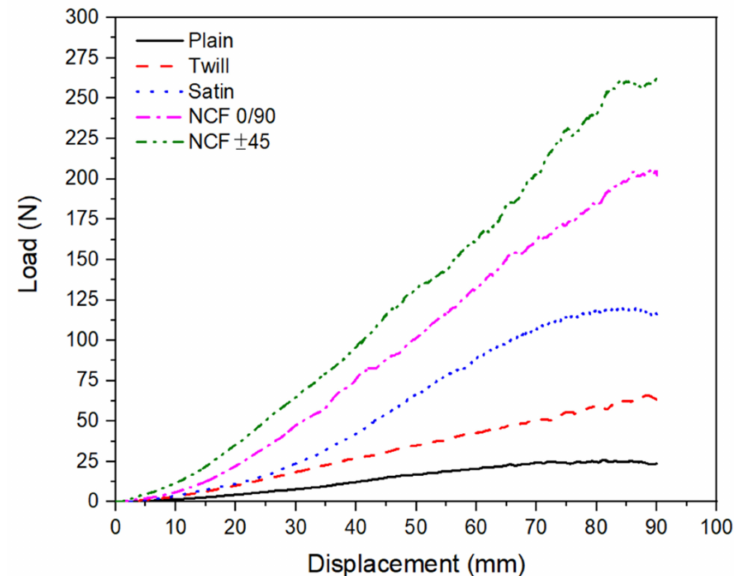
Figure 8. Load vs. displacement for each reinforcement